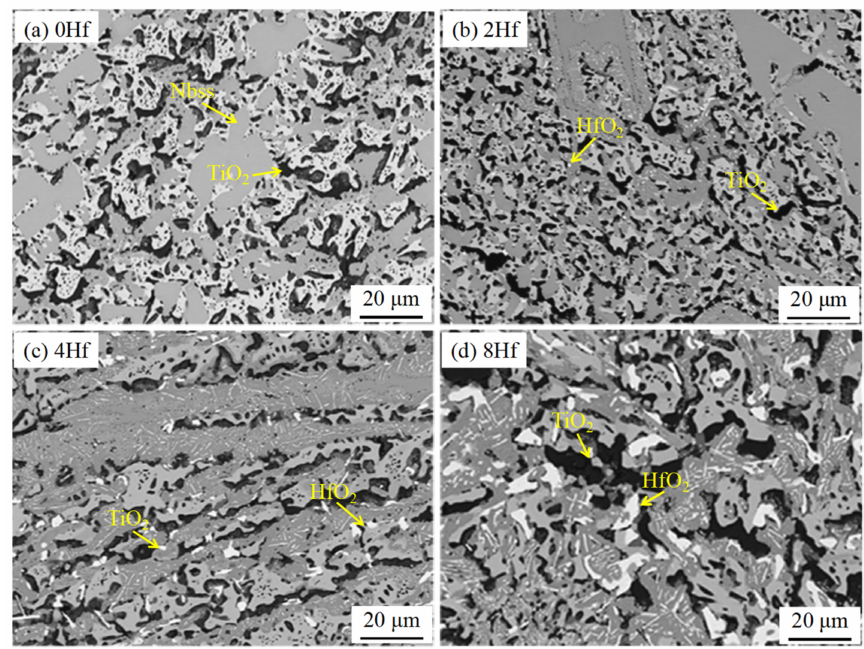
Figure 4. Cross-sectional BSE images of the internal oxidation zones of the Nb-22Ti-16Si-3Cr-3Al-2B- xHf. (x = 0 at.%, 2 at.%, 4 at.%, 8 at.%) alloys upon oxidation at 1250 ◦ C for 50 h.( a ) 0Hf alloy. ( b ) 2Hf alloy. ( c ) 4Hf alloy. ( d ) 8Hf alloy. Copyright 2015